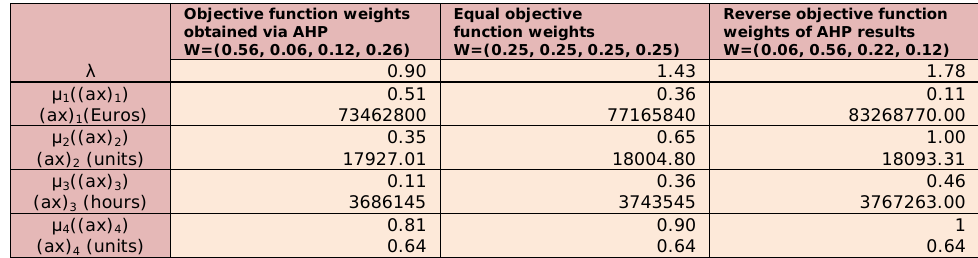
Table 10. Overall satisfaction degrees, membership function and objective functions' values for different weight